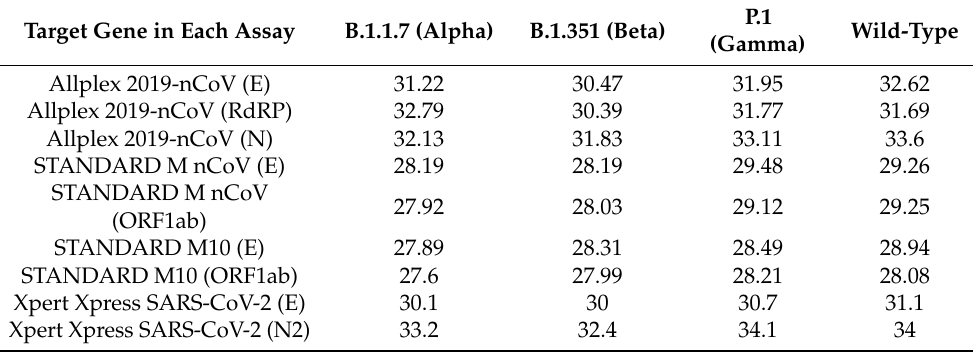
Xpert Xpress SARS-CoV-2 (N2) Ct, cycle